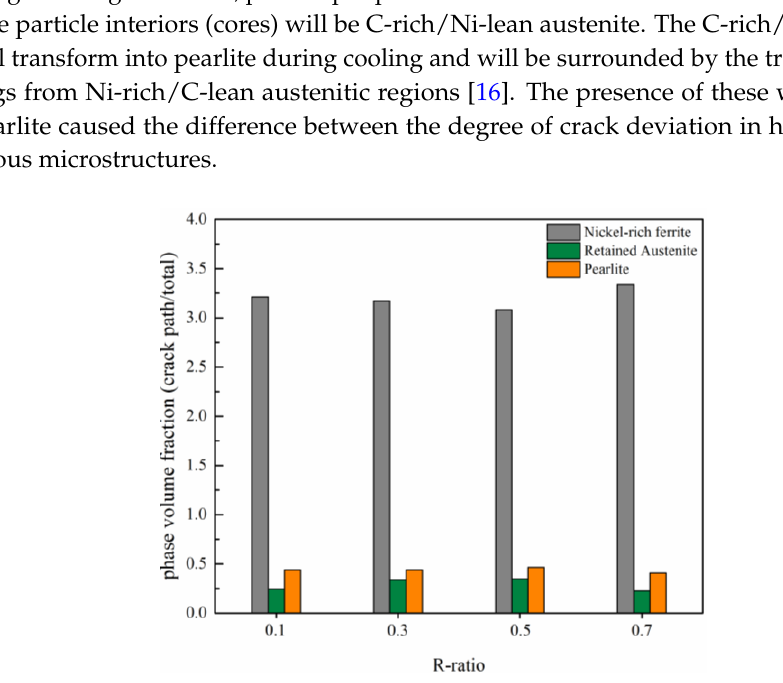
Figure 12. The ratios of the volume fraction of each phase in the crack path to its amounts in the material, for admixed PM steel at different R -ratios.